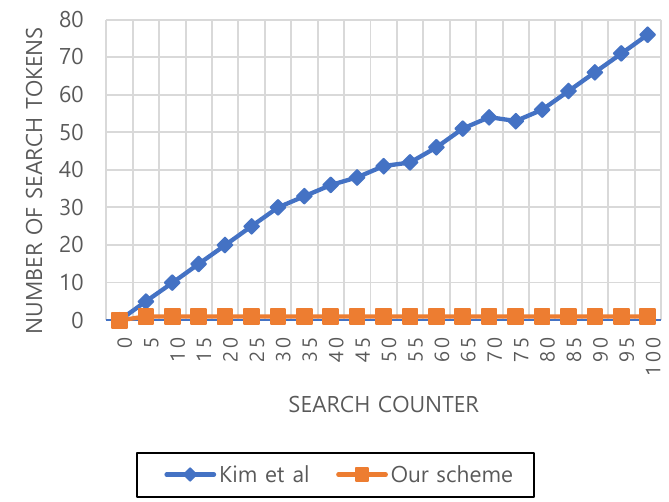
Figure 2. Computational cost of each algorithm.